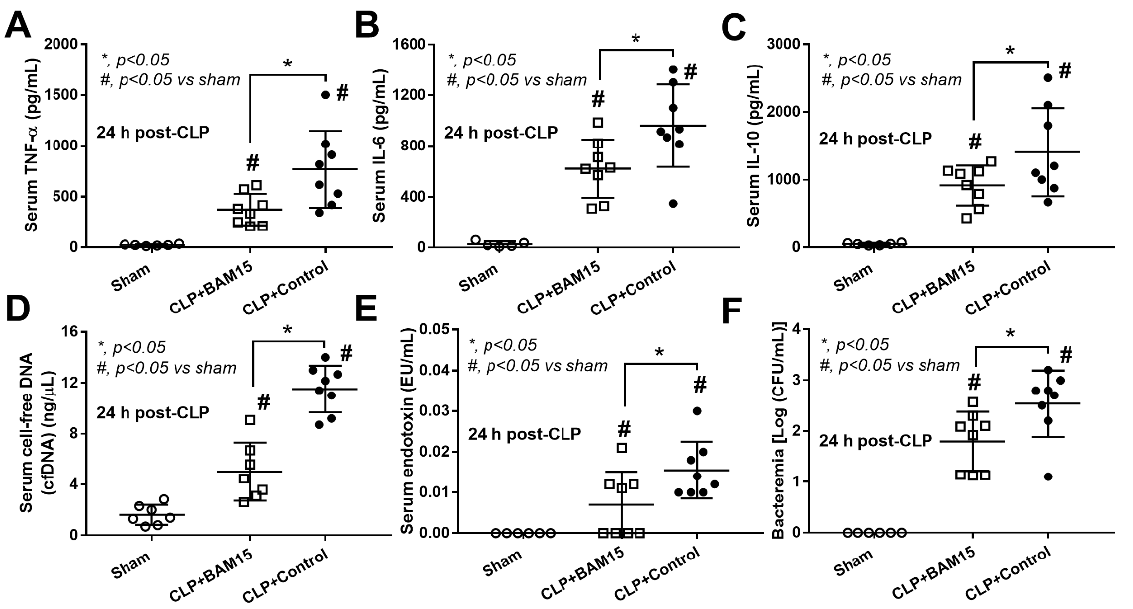
Figure 3. Characteristics of cecal ligation and puncture (CLP) sepsis or sham mice at 24 h after surgery with BAM15 or vehicle (control) as evaluated by serum cytokines (TNF- α , IL-6, and IL-10) ( A – C ), serum cell-free DNA (cf-DNA) ( D ), serum endotoxin ( E ), and bacteremia ( F ) are demonstrated ( n = 6–8/group). #, p < 0.05 vs. sham; *, p < 0.05 vs. the indicated groups as determined by ANOVA with Tukey’s analysis. Data from sham mice with BAM15 are not demonstrated due to the non- significant difference to the sham group.